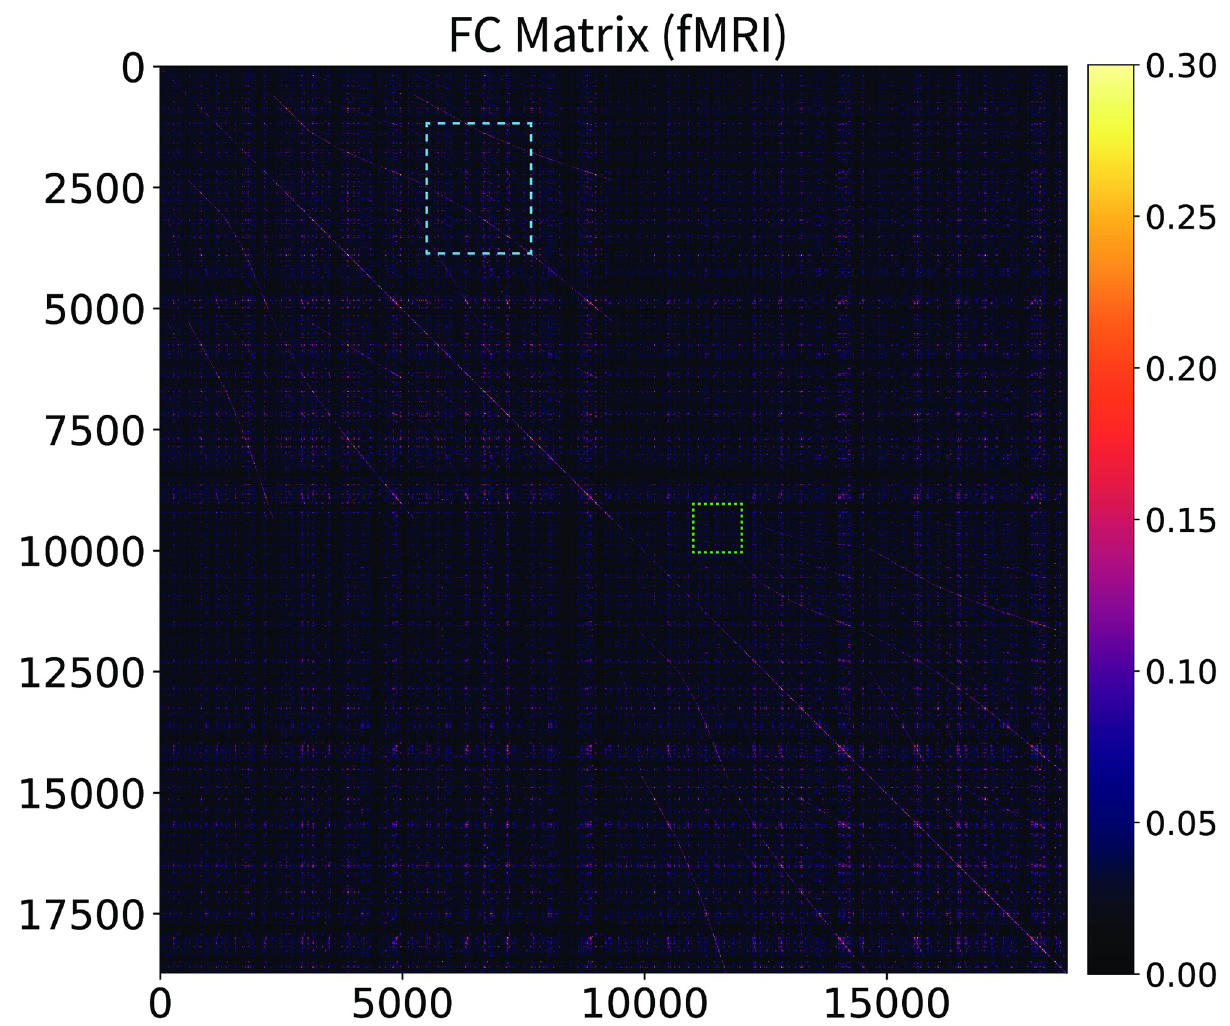
Fig 6. Resting-state fMRI functional connectivity matrix. Connectome-wide, vertex-wise, single-subject, resting-state fMRI functional connectivity matrix. Zoom in to appreciate the patterns present in the data, in particular the two large blocks (top-left and bottom-right) corresponding to the two hemispheres, and the many intra-hemispheric patterns. Compare with the functional connectivity predicted by the stochastic Wilson-Cowan graph neural field (Fig 7). The light-blue and light-green rectangles indicate the insets visualized in Figs 8 and 9.